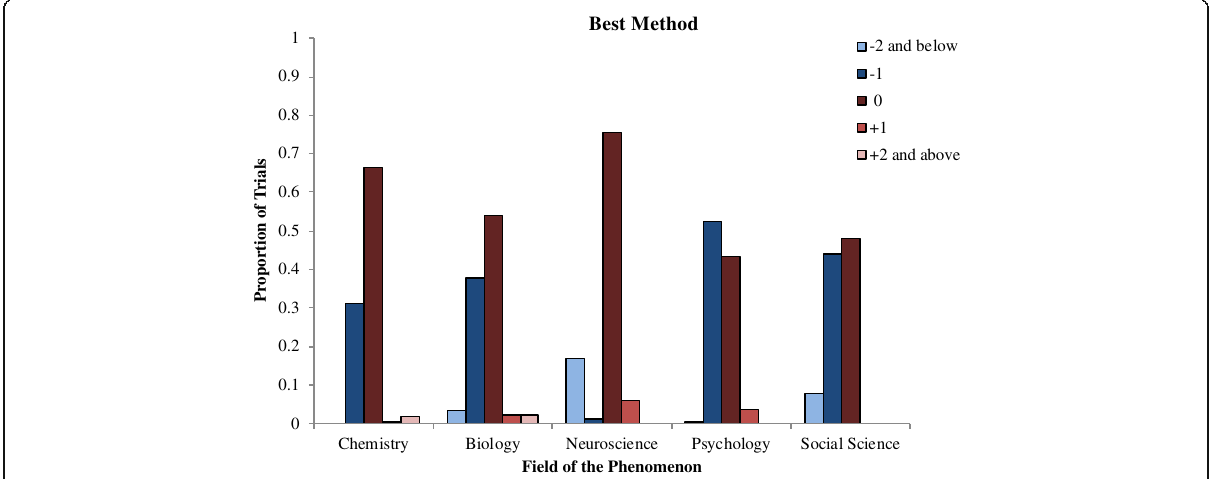
Fig. 2 Proportion of times each level method was selected on the best method question, broken down by the field of the